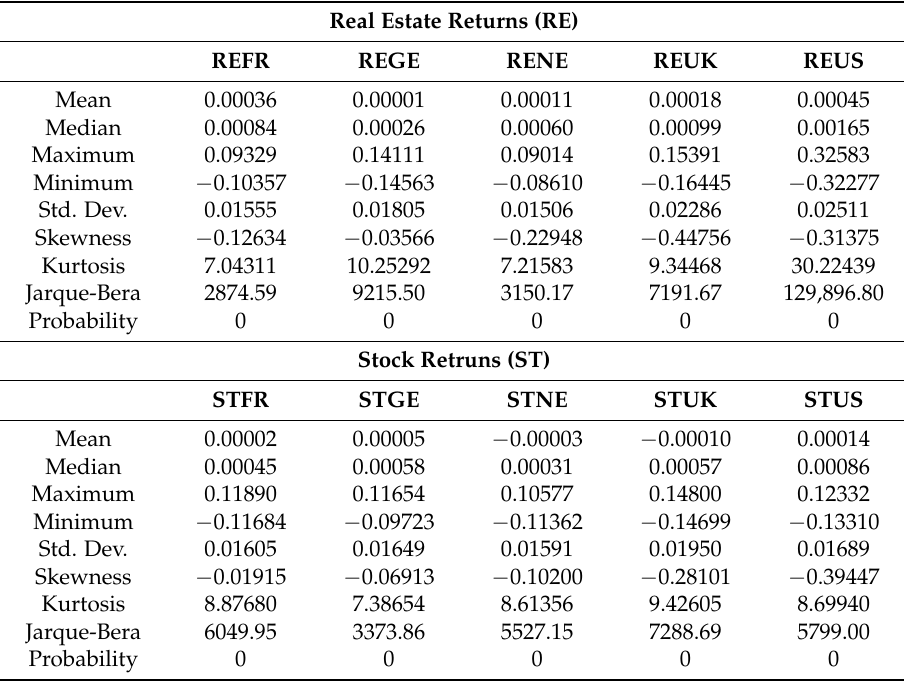
Table 1. Descriptive statistics of daily public real estate and stock returns (local